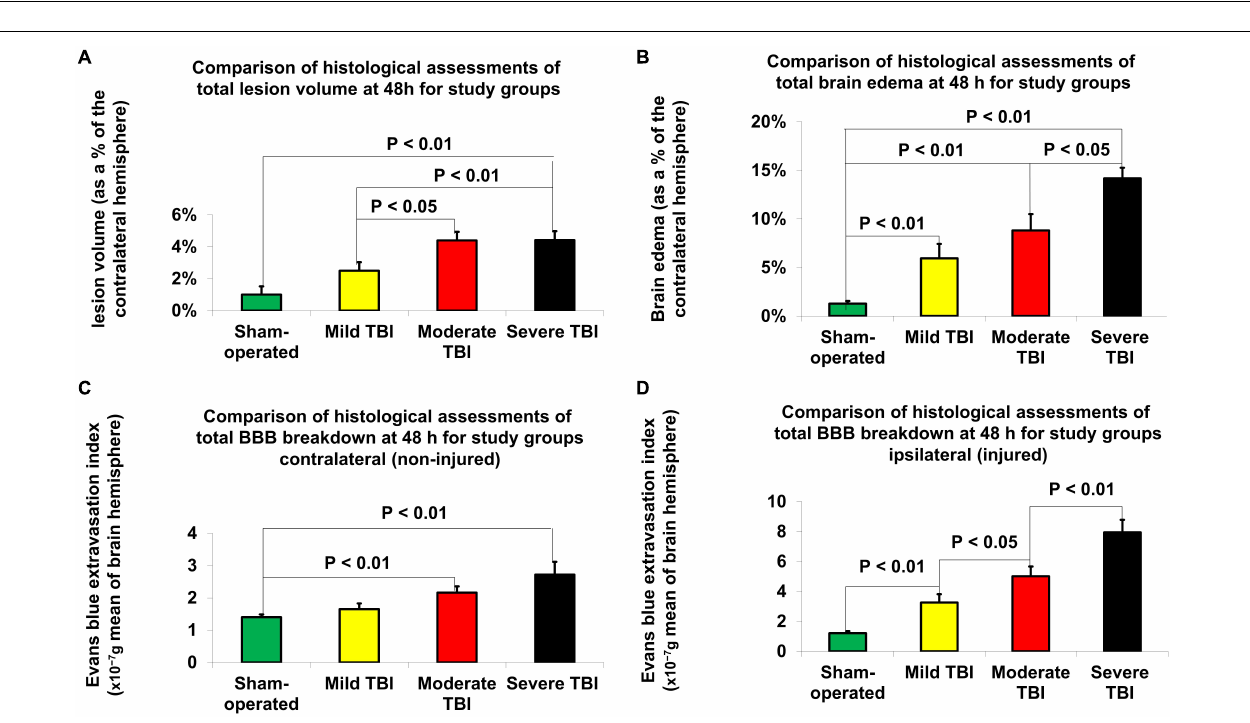
FIGURE 2 | Determination of neurological severity score 48 h after TBI. (A) The neurological severity score (NSS) 48 h after TBI in the different experimental groups. There was a significant difference in NSS between groups 48 h after TBI ( p < 0.05). The data are measured as counts and presented as median ± range. (B) Comparison of significant differences (displayed as the p value) between the NSS of different experimental groups.